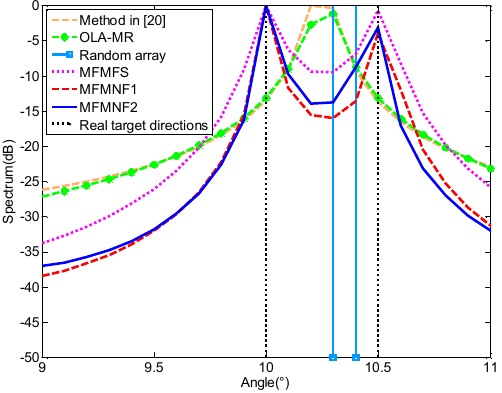
Figure 6. MUSIC spectra for D = 2 sources on a ULA with seven sensors.